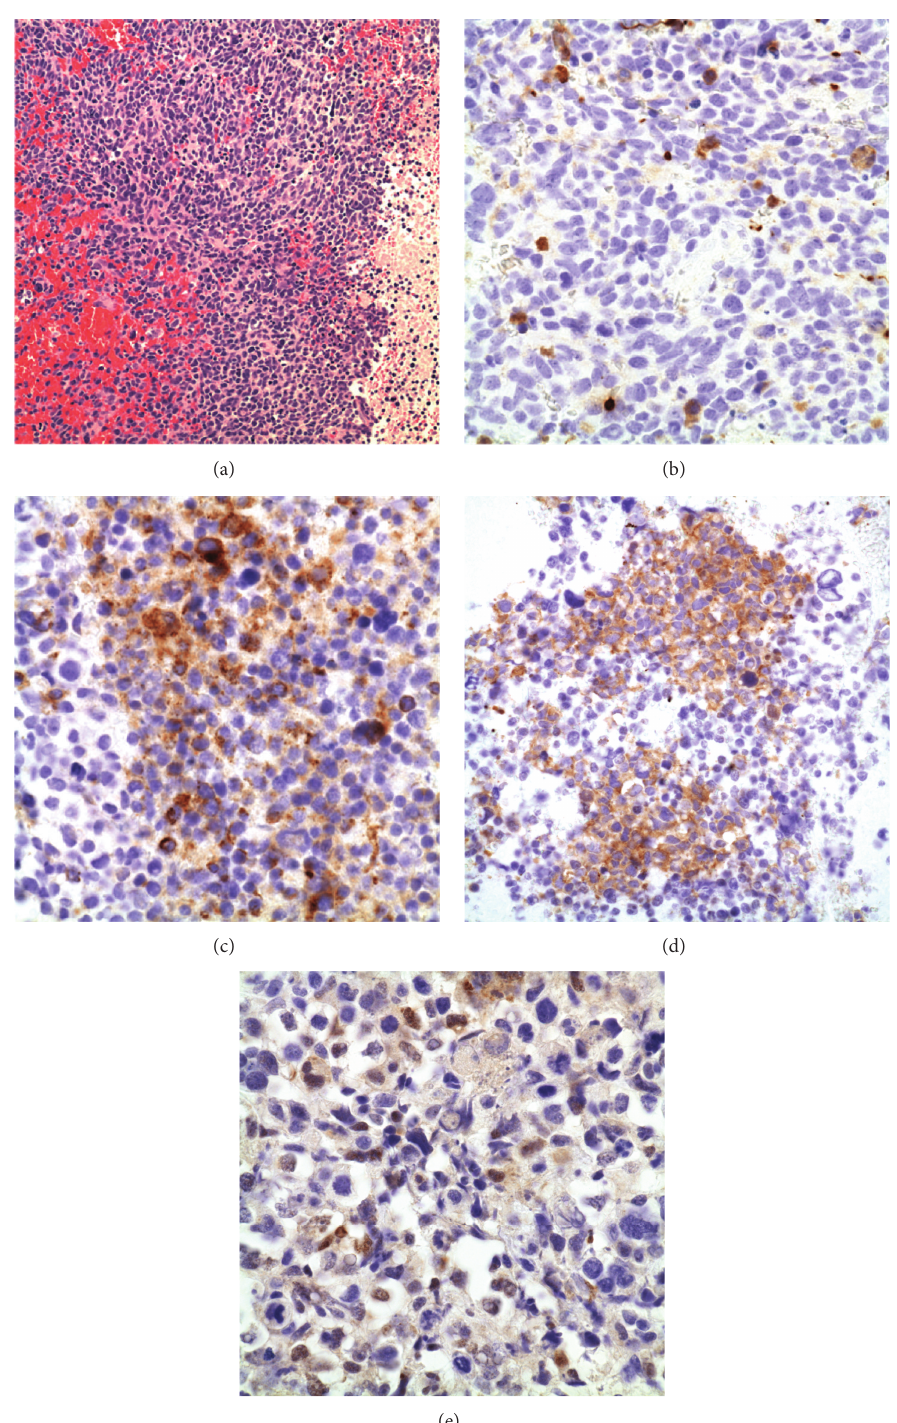
Figure4:Tissueremovedfromthesecondcraniotomy.(a)Thetumorisadenselycellularlesioncomposedmostlyofsmallcellswithsmallcell bodies (H&E, original magnification 200x). (b) A GFAP immunostain marks scattered single cells representing entrapped reactive astrocytes, 600x. (c) A Synaptophysin immunostain labels the cytoplasm of multiple tumor cells, surrounding their centrally-located nuclei (600x). (d) A neurofilament protein immunostain also labels the cytoplasm of many tumor cells as well as some processes from them (400x). (e) A Neu-N immunostain distinctly labels the nuclei of many tumor cells